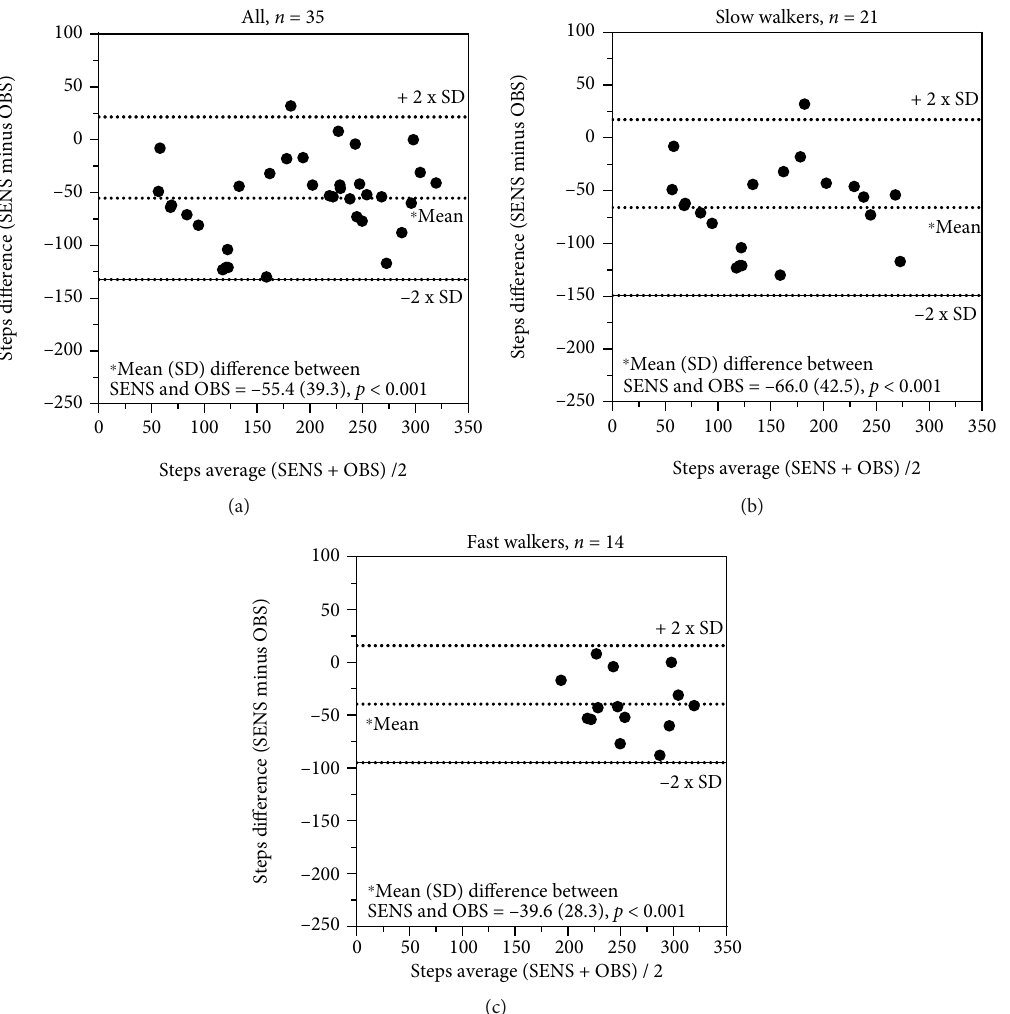
Figure 2: (a – c) Recording of steps: comparison between SENS motion® and direct